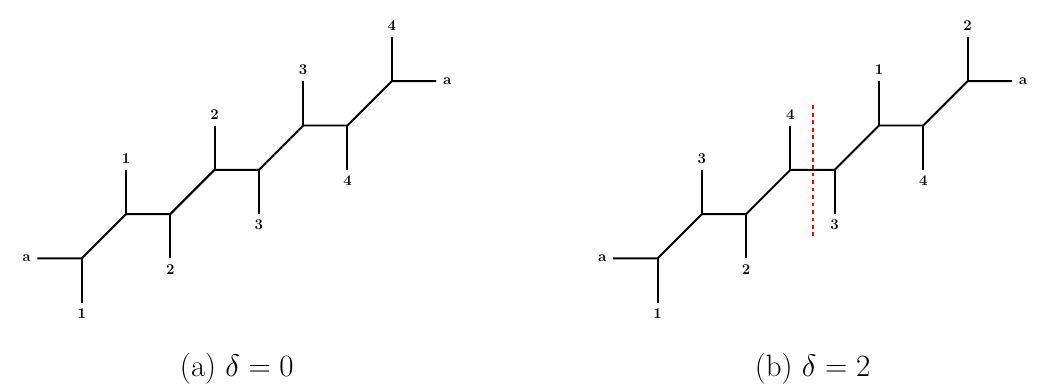
Figure 11 . Toric web diagram for the con(cid:12)guration ( N; M ) = (4 ; 1) with shift (cid:14)